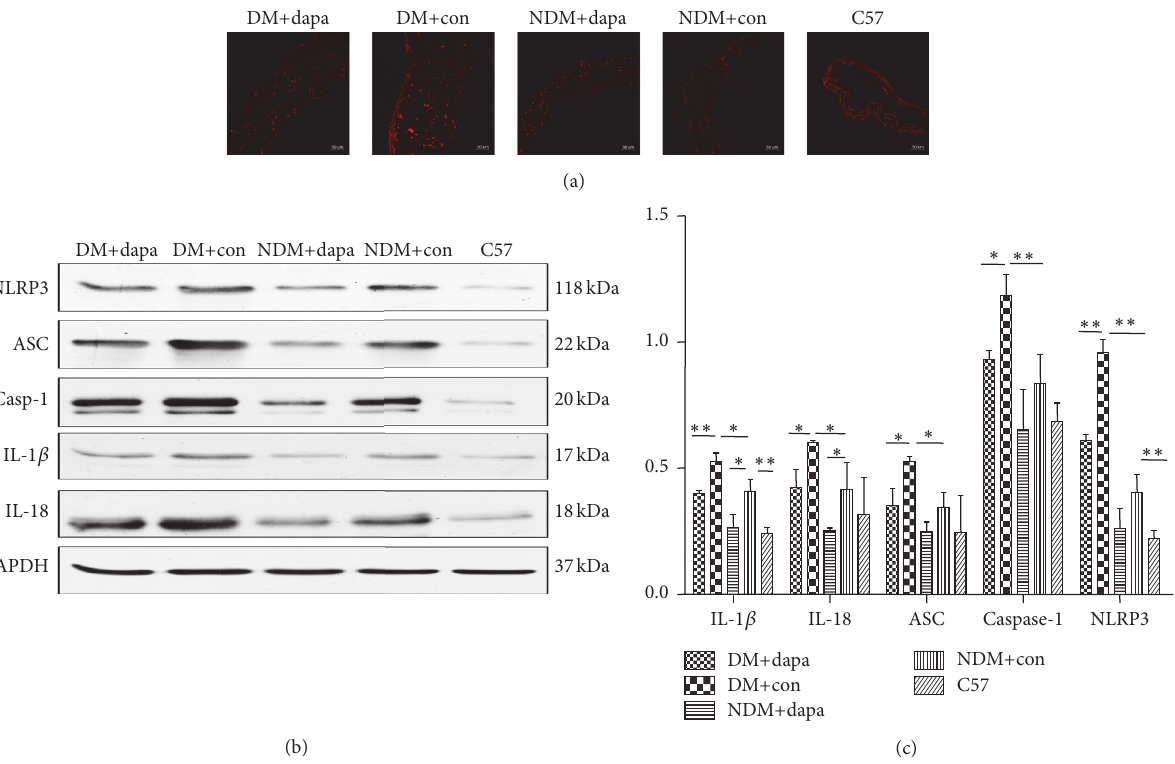
Figure 5: Dapagliflozin attenuated the formation of ROS and NLRP3 inflammasome in DM ApoE −/− mice. Decreased ROS formation in aortic tissues of diabetic ApoE −/− mice was attenuated by dapagliflozin treatment (a). The expression of NLRP3 inflammasome, IL-1 𝛽 , and IL-18 in aortic tissues of mice from each group (b). Western blot analysis was used to detect the protein expression levels with the antibodies against NLRP3, ASC, caspase-1, IL-1 𝛽 , and IL-18. GAPDH was used as loading control (c). ∗ 𝑝 < 0.05 ; ∗∗ 𝑝 < 0.01